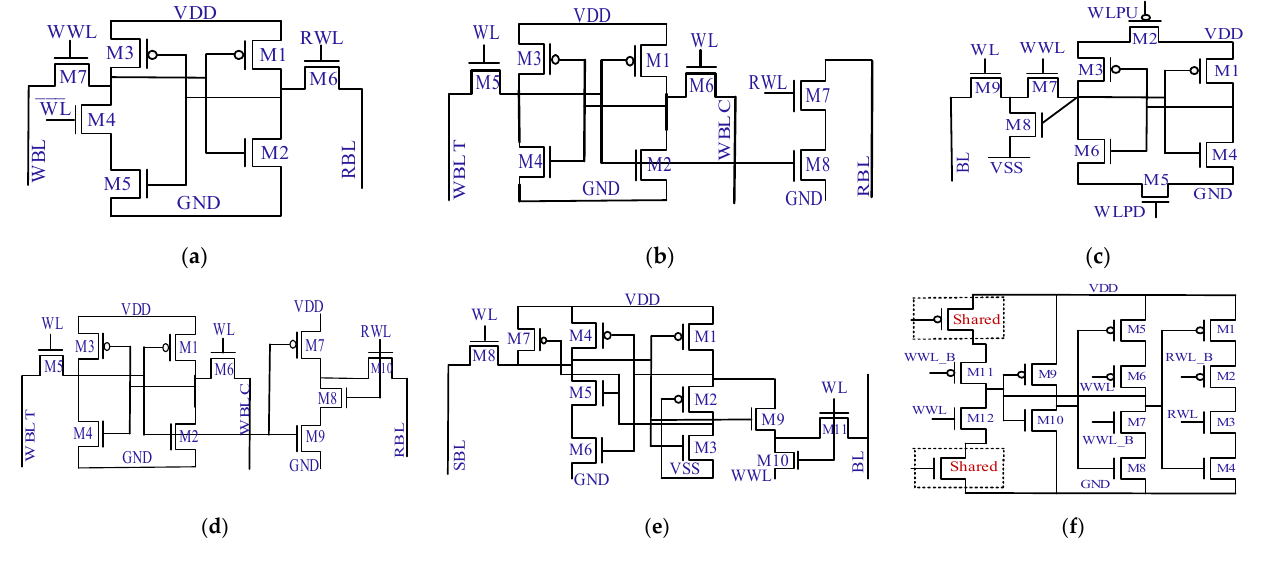
Figure 6. Alternate SRAM cell designs for low voltage operation using feedback break, isolated port, power-gating, buffered values, read or write independency and concurrent read or write strategies. ( a ) 7T-SRAM cell [26], ( b ) 8T-SRAM cell [27] ( c ) 9T-SRAM cell [28], ( d ) 10T-SRAM cell [29], ( e ) 11T- SRAM cell [30], ( f ) 12T-SRAM cell [31].